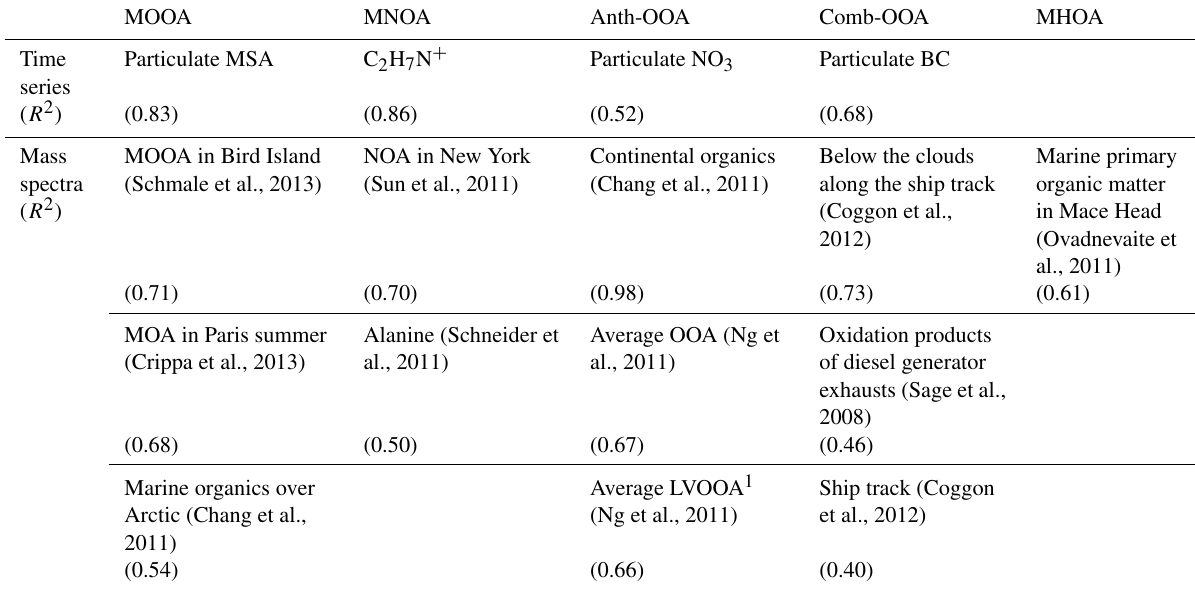
Table 4. Summary of correlations of time series and mass spectra for the five-factor PMF solution. MOOA MNOA